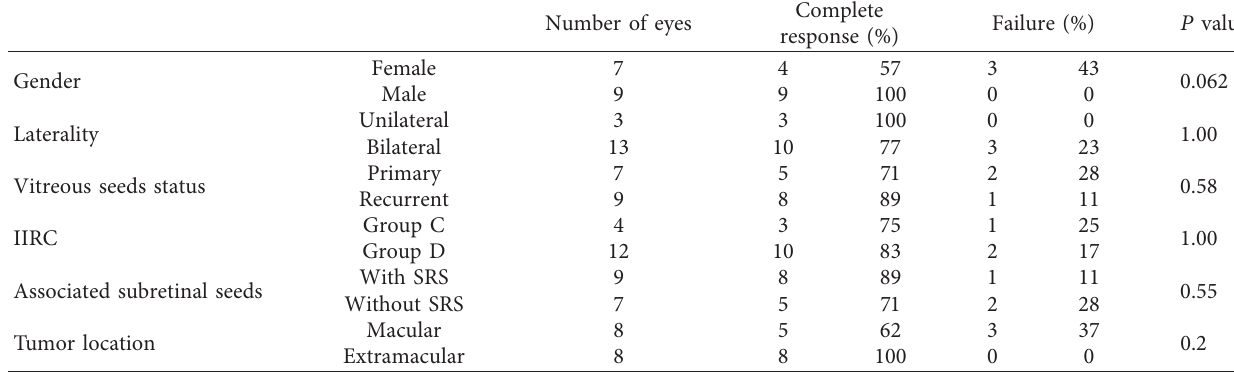
Table 1: Demographics and management outcome.